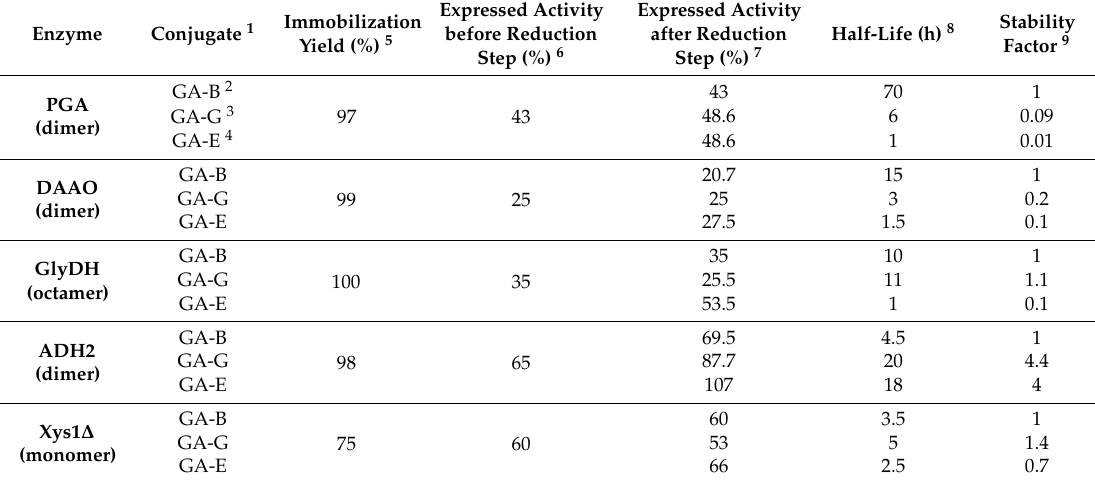
Table 1. Summary of the protein immobilization–stabilization